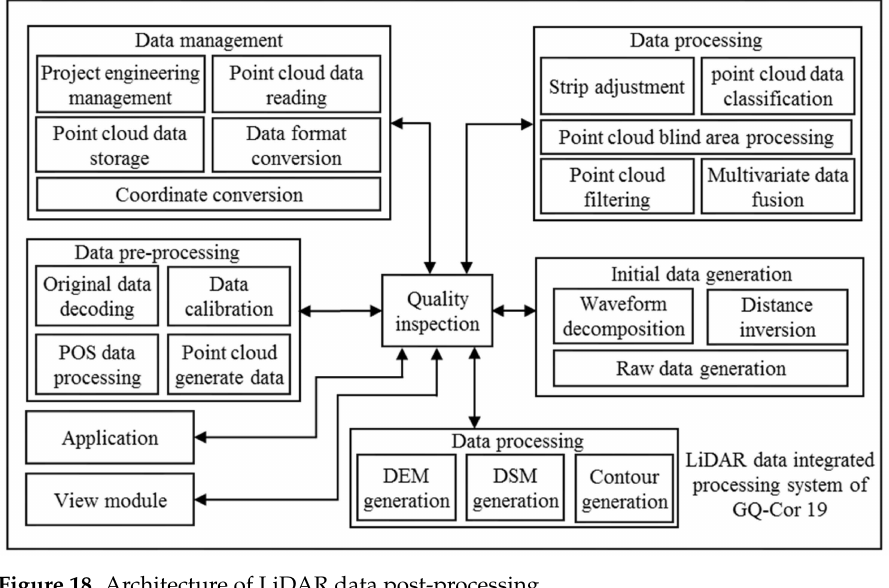
Figure 18. Architecture of LiDAR data post-processing.